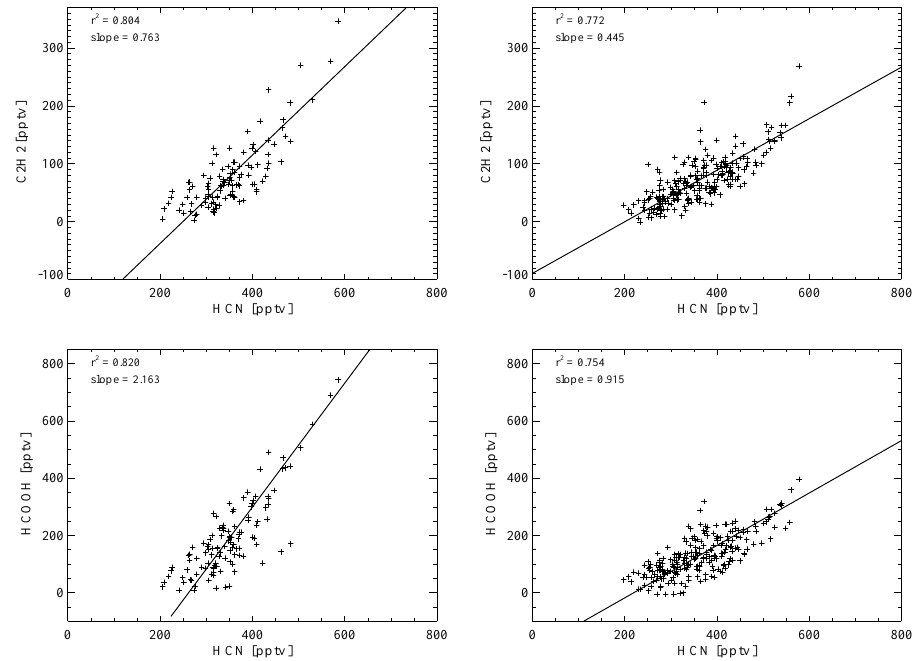
Fig. 15. Top: southern hemispheric (60 ◦ S to Equator) enhanced MIPAS C 2 H 2 data plotted versus enhanced MIPAS HCN data of the time periods 9 to 15 February 2009 (left) and 16 to 22 February 2009 (right), along with fitted regression lines. Data are from the altitude region 17–21km and converted to identical vertical resolution; r 2 and slope are the correlation coefficients and slopes of the regression lines. Bottom: same as top panel, but for MIPAS HCOOH versus HCN